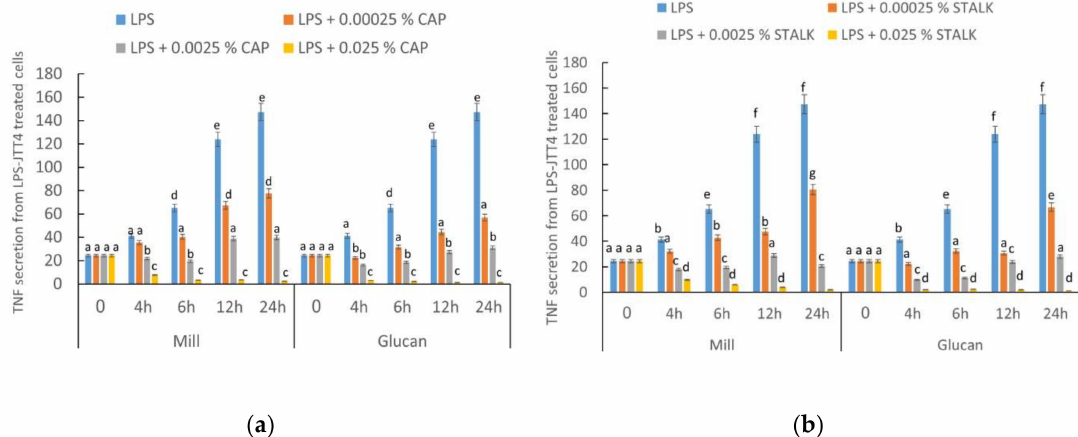
Figure 1. Secretion of lipopolysaccharide (LPS)-stimulated TNF- α by J774.1 (1 × 10 6